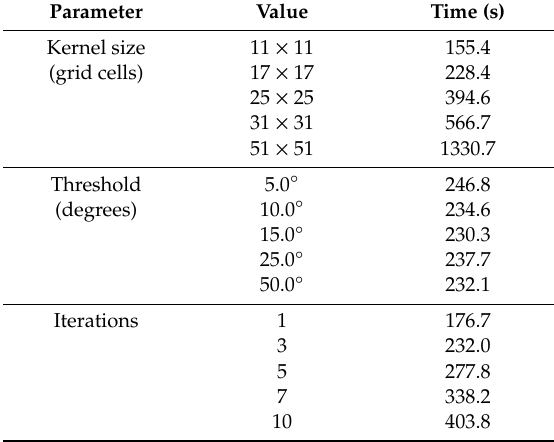
Figure 5. The effect of altering the FPDEMs filter size for two small areas within the study DEM. Each smoothing operation was run with a normal vector di ff erence threshold of 15 ◦ and five elevation-update iterations. Images present portions of the shaded relief images extracted from each DEM. Table 1. The impact of varying parameter setting values on the processing performance of the FeaturePreservingSmoothing tool. Processing times include file input / output. The kernel size tests used a threshold of 15 ◦ and three iterations, the threshold tests used 17 × 17 kernels and three iterations, and the iteration tests used 17 × 17 kernels and a threshold of 15 ◦